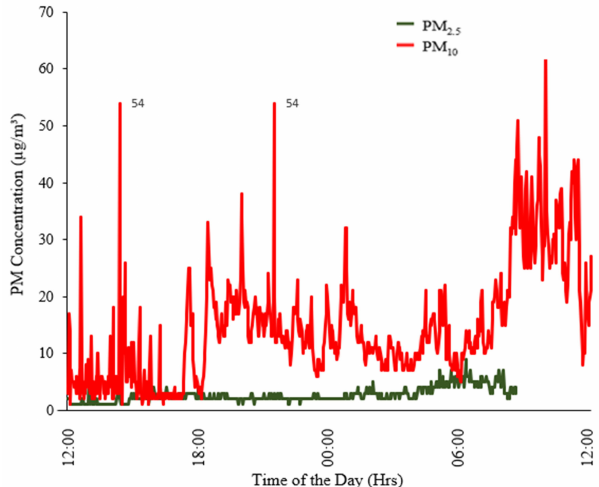
Atmosphere 2022 , 13 , 984 Figure 2. Daily variations of PM 2.5 and PM 10 concentrations during 8 ‐ 9 November 2018. Figure 2. Daily variations of PM 2.5 and PM 10 concentrations during 8-9 November 2018.